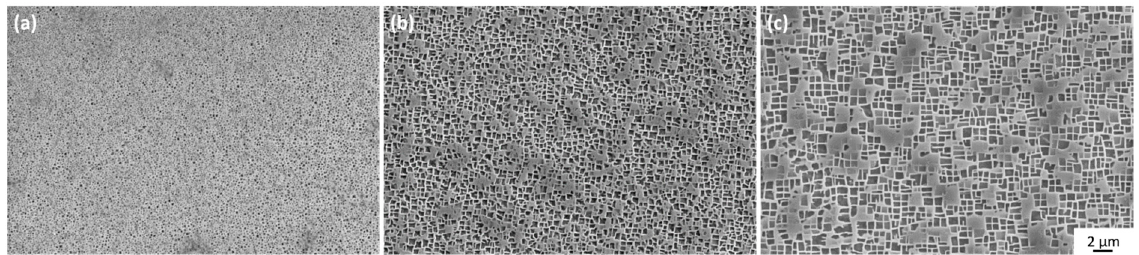
Figure 11. Microstructure of AM1 in dendrite core after solution treatment followed by: ( a ) a water quench, ( b ) an air quench and ( c ) a gas furnace cooling.